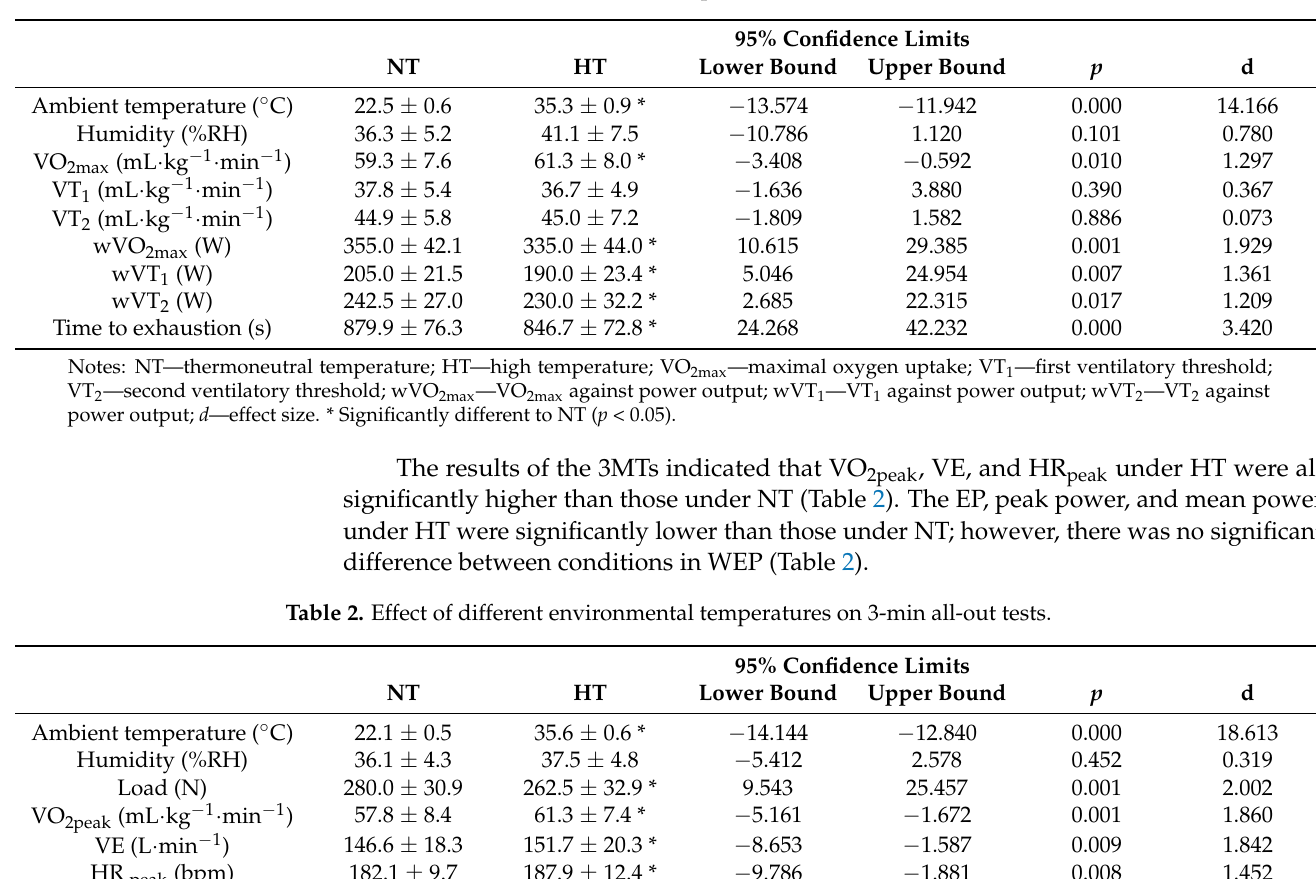
Table 1. Effect of different environmental temperatures on incremental exercise tests.